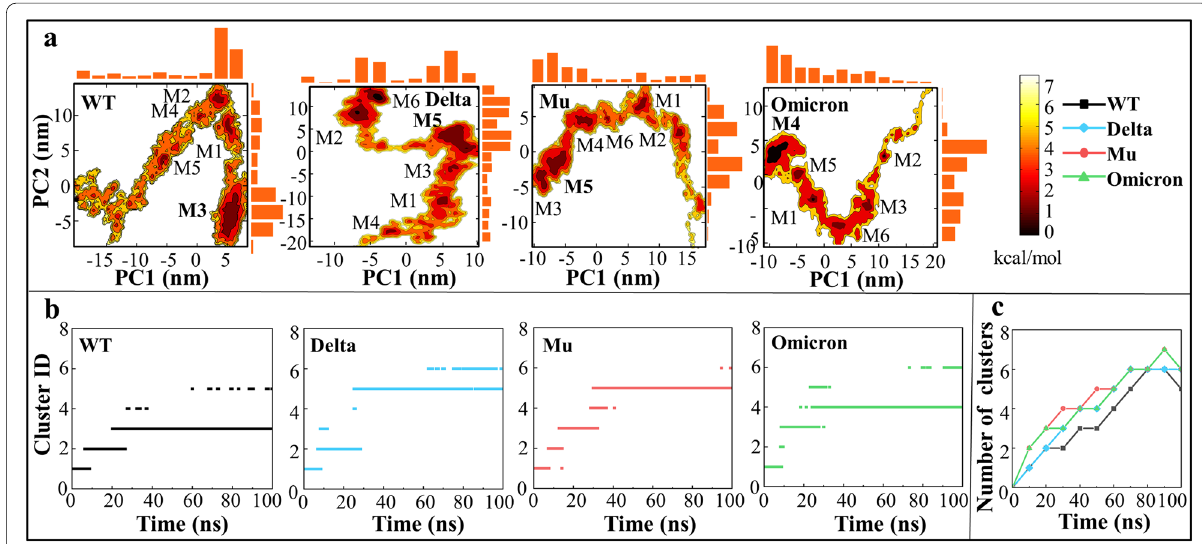
Fig. 2 a Free energy landscapes of the WT, Delta, Mu, Omicron systems, b the corresponding conformational cluster analyses as well as c the number of clusters over simulations time. The darker the color in FEL diagram, the lower the conformational free energy